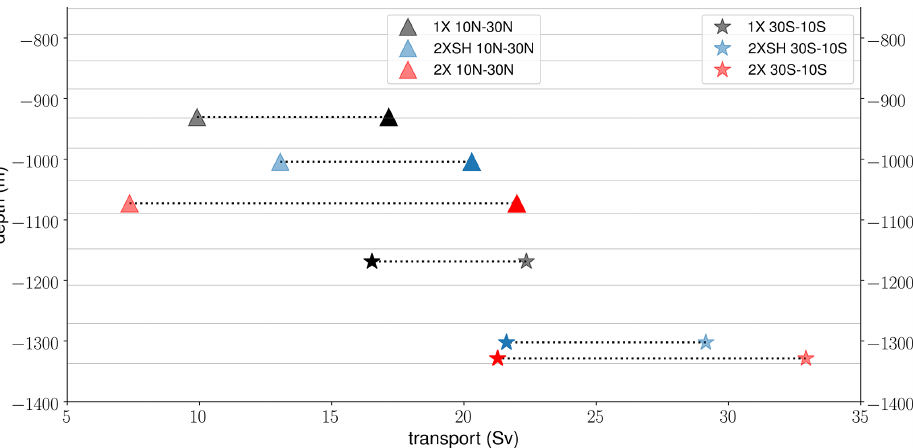
Figure 6. The time-mean (1991–2010) relationship between maximum overturning and its depth, the level of no motion (as plotted on the y axis), in the Southern Hemisphere and the Northern Hemisphere. The markers represent the meridional averages (30–10 ◦ S) (stars) and (10–30 ◦ N) (triangles). The figure shows both the total maximum overturning streamfunction ( ψ t , opaque) and the geostrophic maximum overturning streamfunction ( ψ g , transparent). The qualitative behavior does not differ when plotting the pycnocline scale η ρ (not shown) instead of the level of no motion η ψ , except that the pycnocline scales of the 2XSH and 2X experiments are congruent throughout the basin. The thin gray lines indicate the vertical model